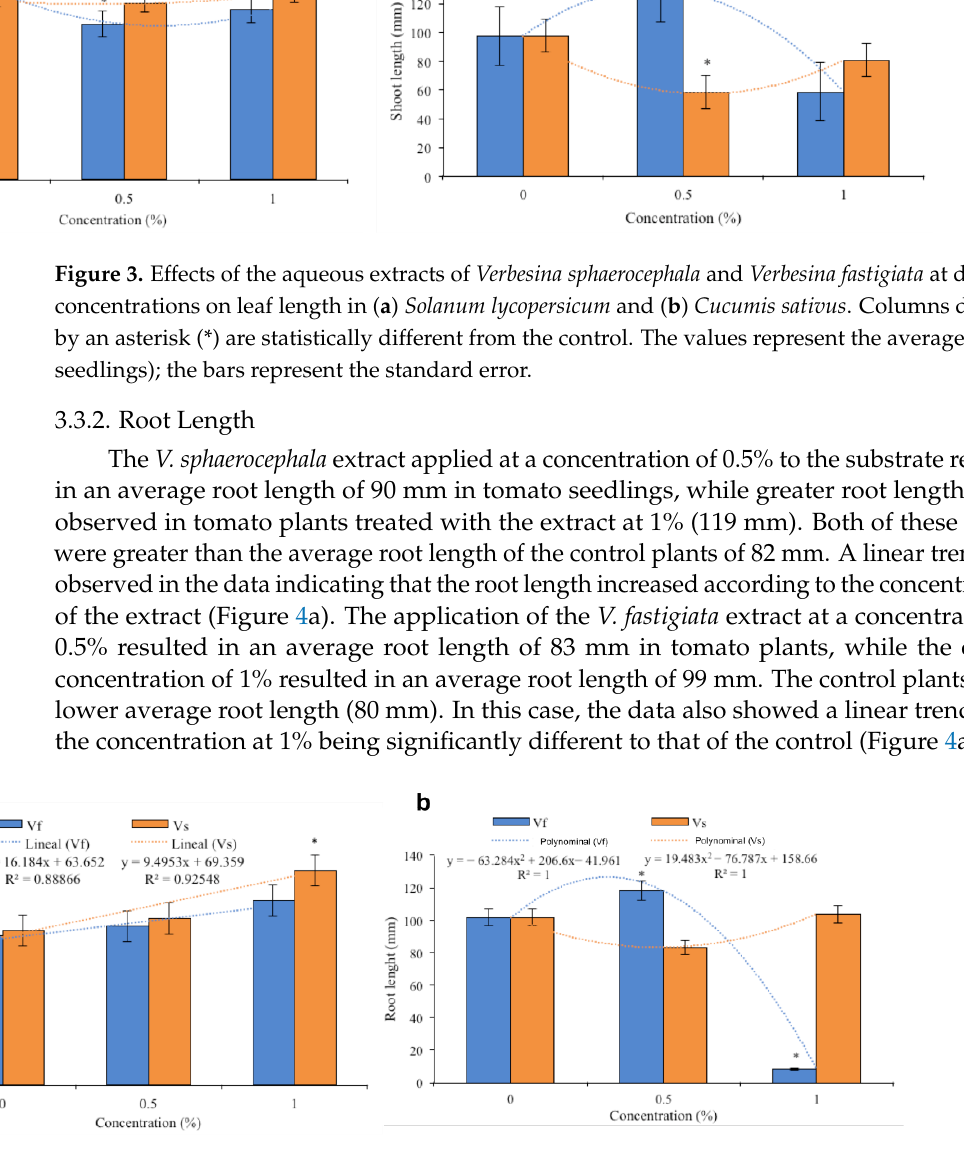
Figure 5. Effects of the aqueous extracts of Verbesina sphaerocephala and Verbesina fastigiata at different concentrations on leaf area in ( a ) Solanum lycopersicum and ( b ) Cucumis sativus . Columns denoted by an asterisk (*) are statistically different from the control. The values represent the average ( n = 20 seedlings); the bars represent the standard error. The application of V. sphaerocephala extracts at 0.5 and 1.0% resulted in leaf areas of 1300 mm 2 and 2000 mm 2 in cucumber seedlings; however, both concentrations resulted in leaf areas that were lower than that of the control treatment (2300 mm 2 ). The data showed a polynomial trend, with elevated values in the control treatment that decreased with the application of the extract at a concentration of 0.5% and increased with the application of